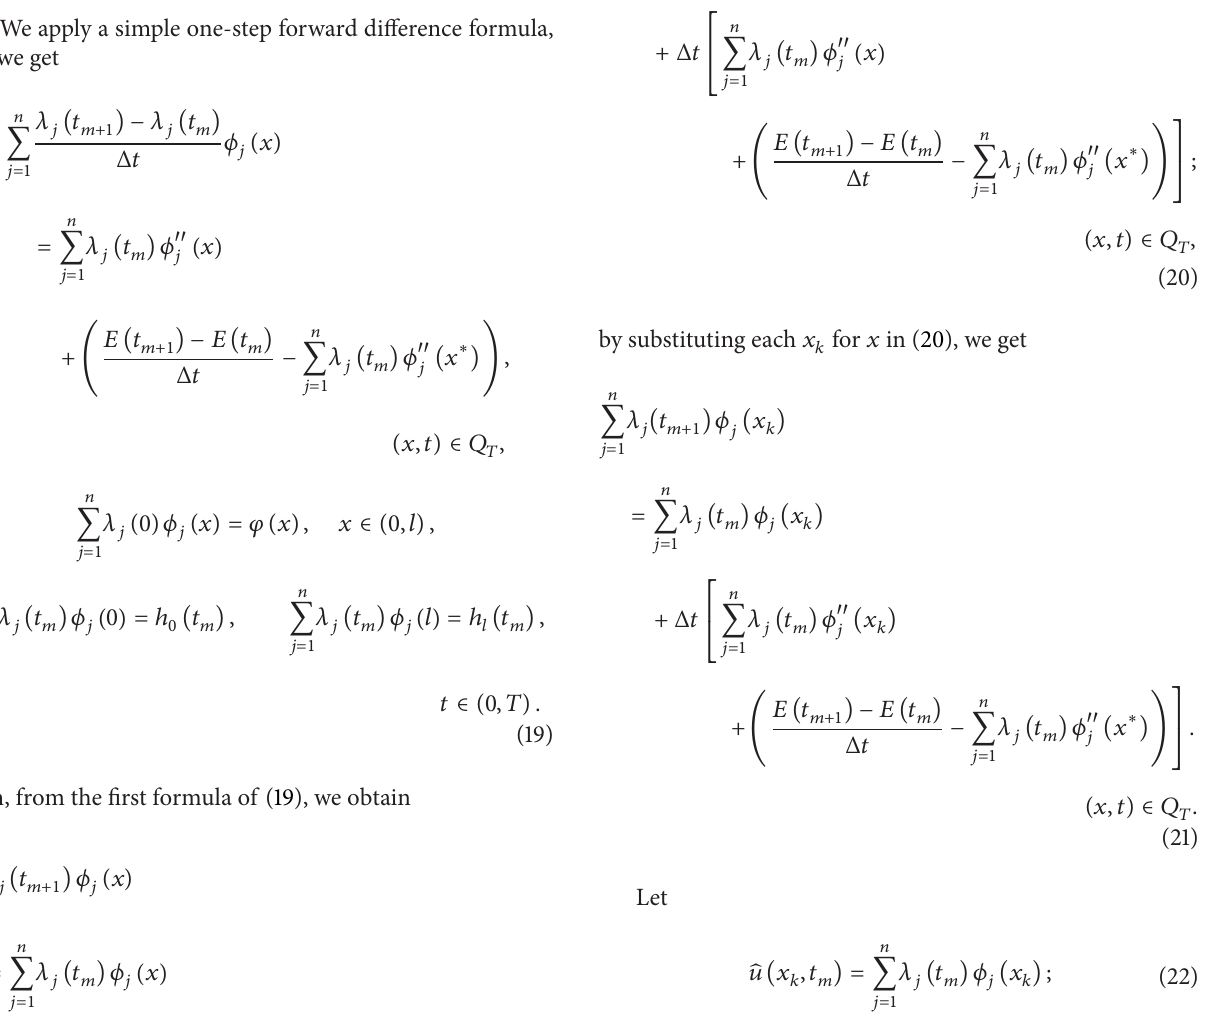
Figure 8: The exact solution 𝑓(𝑡) and the numerical solution of of 𝑡 . We apply a simple one-step forward difference